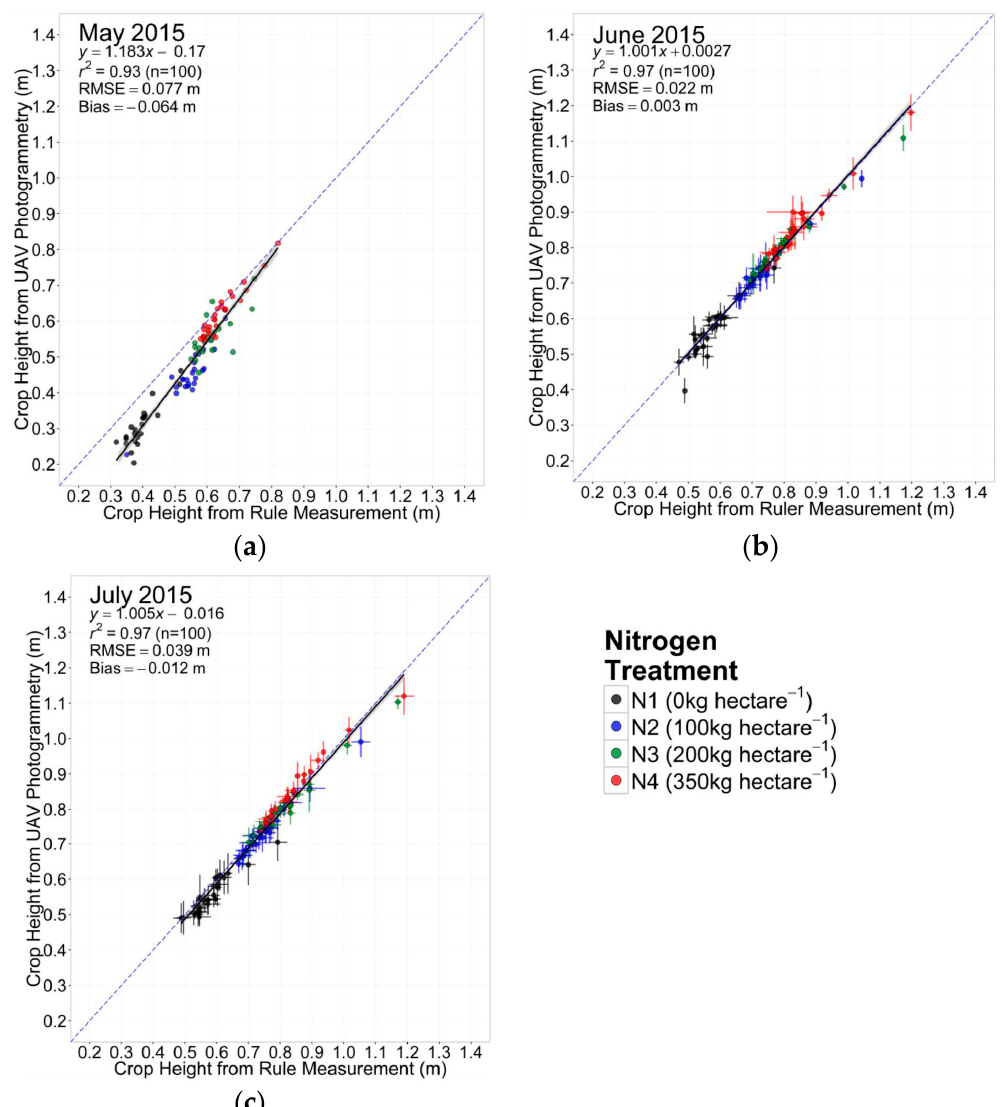
Figure 10. The 2015 accuracy assessments of UAV-derived mean crop heights made against standard ground-based rule measures performed as per Section 2.2). Accuracy assessment covered the four nitrogen treatments in: ( a ) May 2015 where the crops were still growing; and ( b ) June 2015; and ( c ) July 2015 when the crops were post anthesis and no longer expected to grow. The error bars represent the standard deviation of crop height between the three replicates from each cultivar and treatment. The blue dashed line indicates a 1:1 slope.